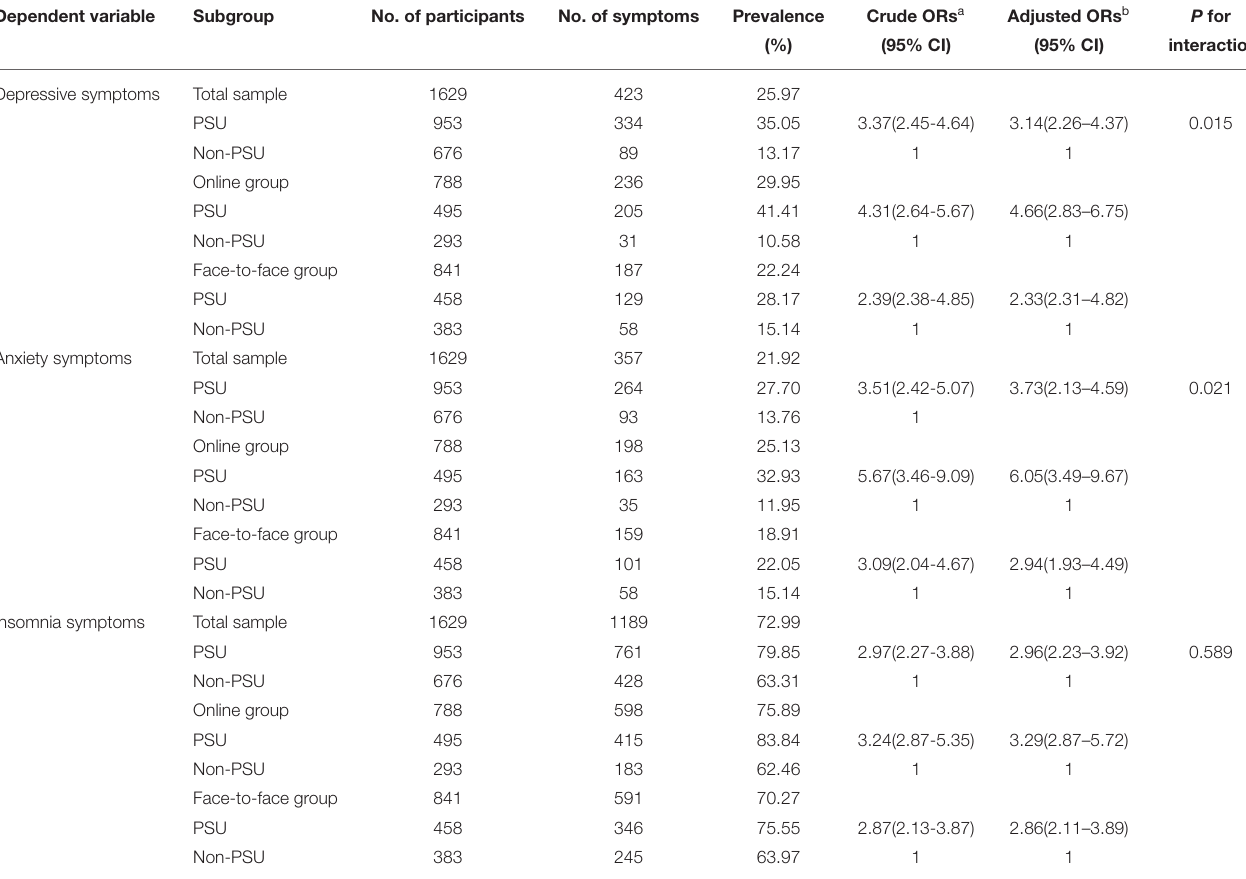
TABLE 3 | Stratified logistic regression analyses of PSU and mental health symptoms across education modes. Dependent